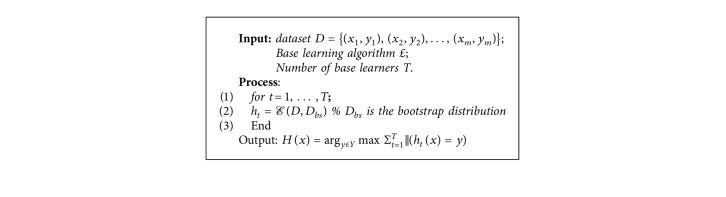
 Bagging algorithm.